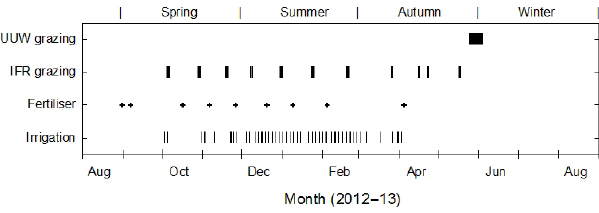
Figure 2. Pasture management regime from 17 August 2012 to 16 August 2013. Bars indicate the time and duration of grazing events in the UUW and IFR paddock. Crosses and vertical lines respectively mark times of fertiliser and irrigation applications to the IFR